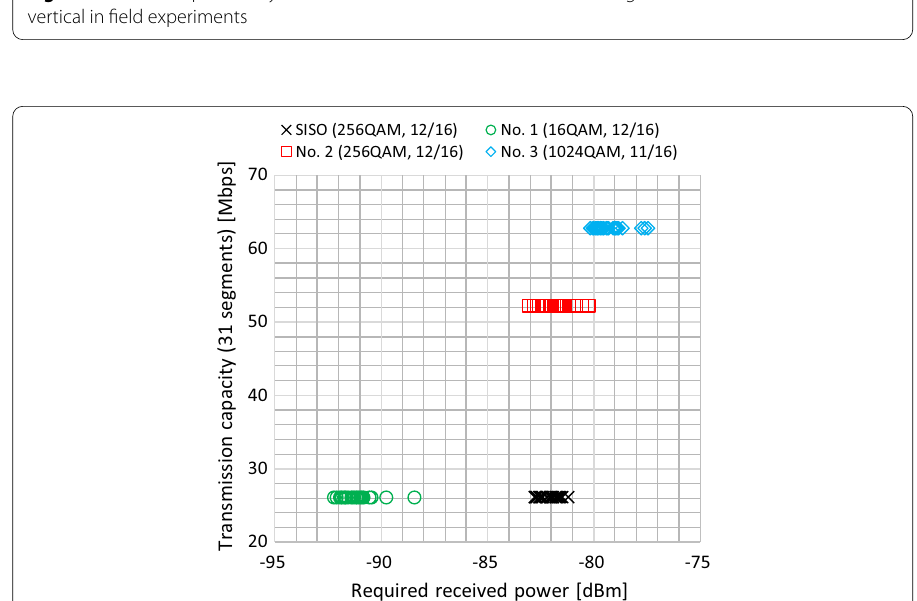
Fig. 16 Distribution of required received power for all parameter